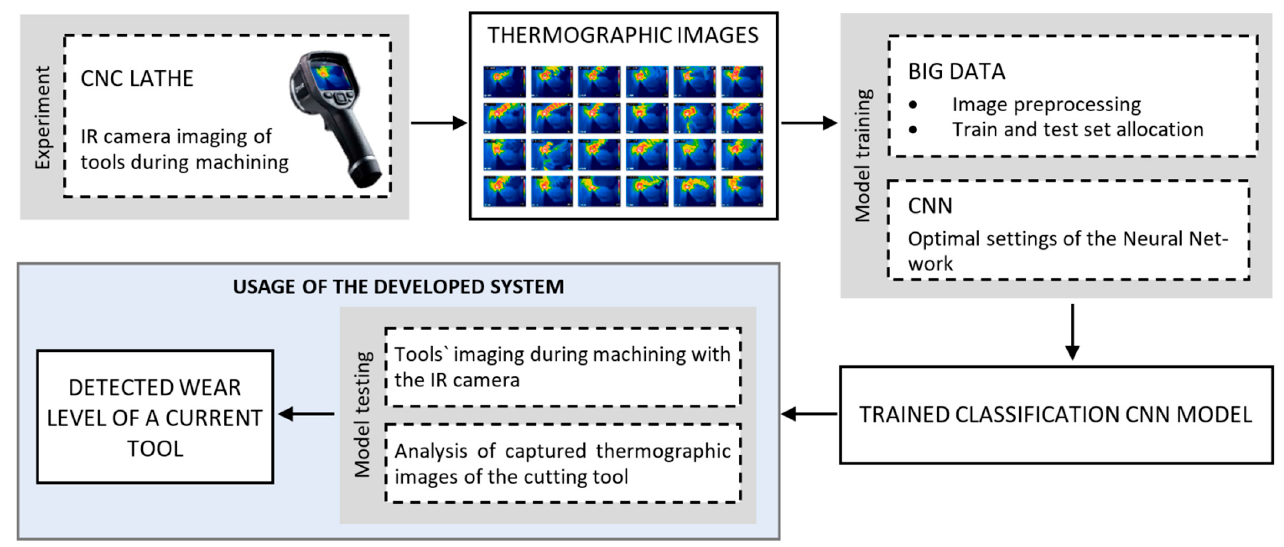
Figure 2. Schematic representation of the model for an intelligent control of the cutting tool wear level and breakage, using thermography.